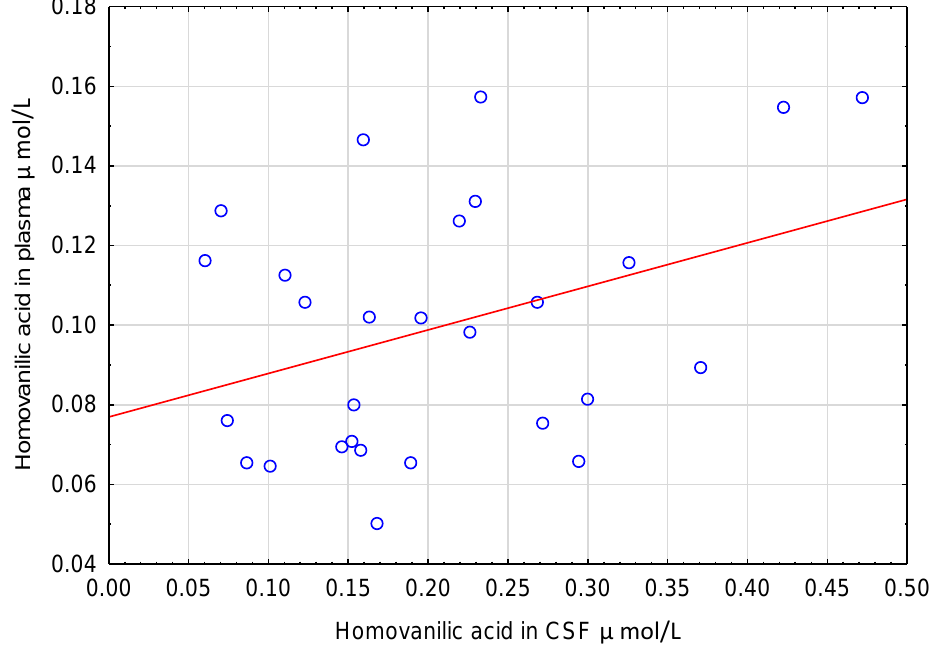
Figure 5. Scatter plot of homovanillic acid concentration in plasma (Y) and cerebrospinal fluid (X). No significant correlation was found between these two variables ( ρ = 0.272, p = 0.161, n = 28). CSF—cerebrospinal fluid.